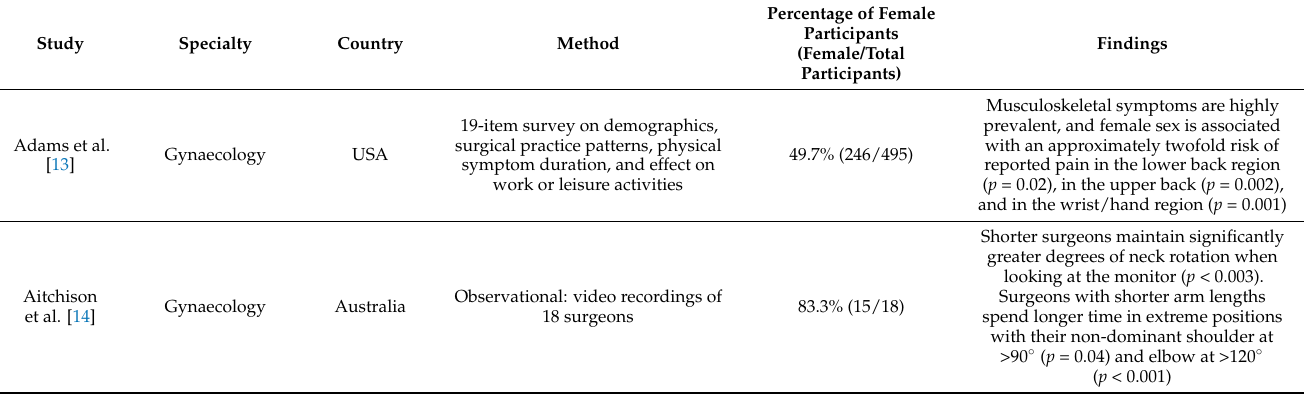
Table 2. Study characteristics, aims, and main